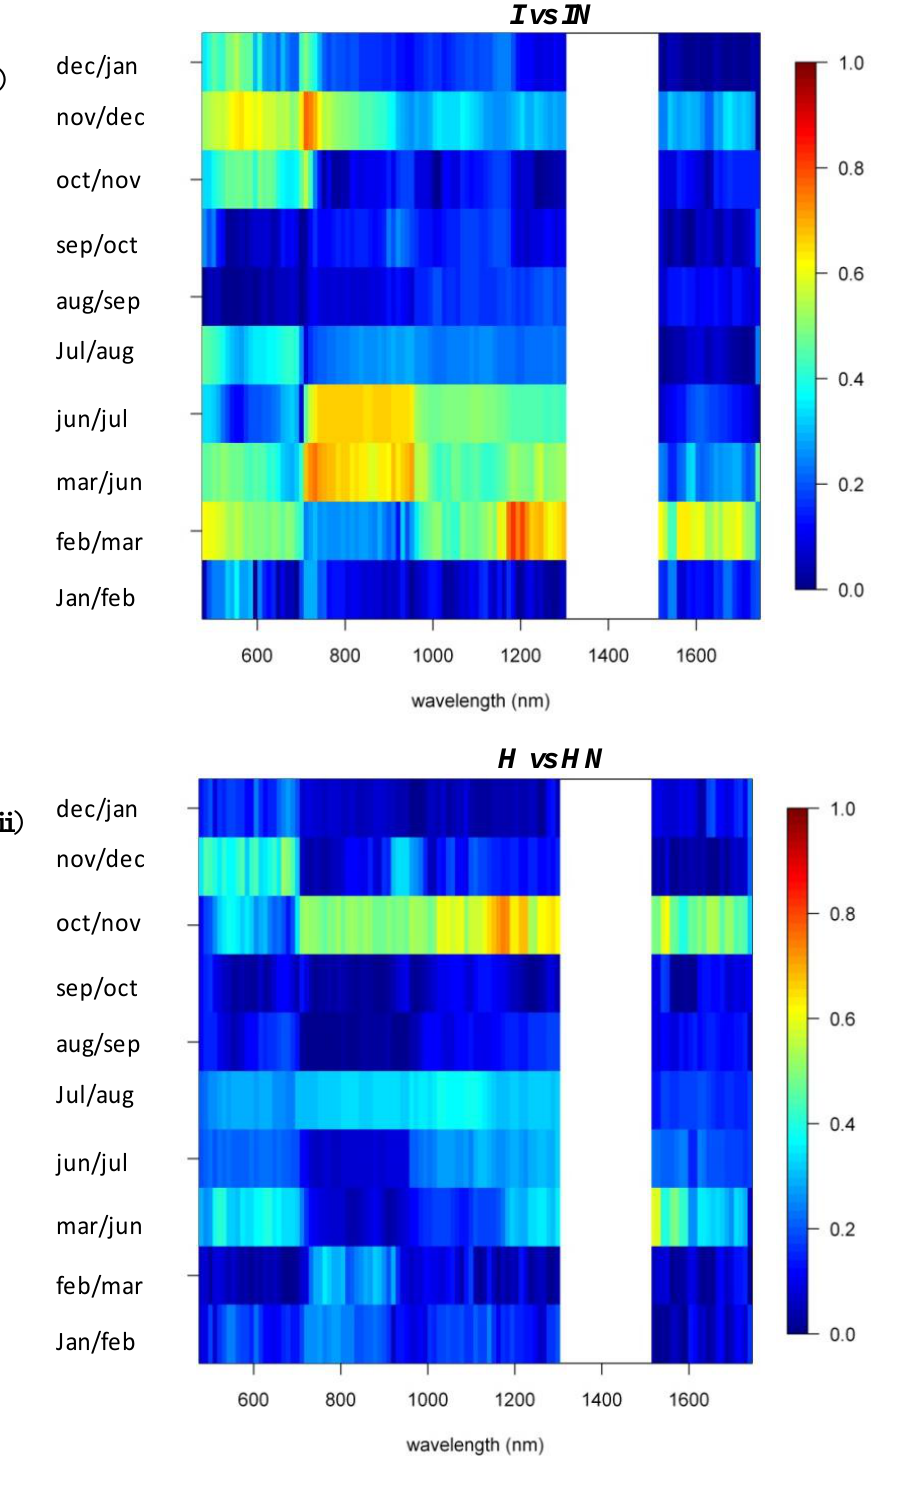
Figure 5. The spectro-temporal SI charts for the pairwise comparison of ( i ) invasives and ( ii ) natives of the temporal displacement spectra ( i.e. , temporal derivatives). I vs